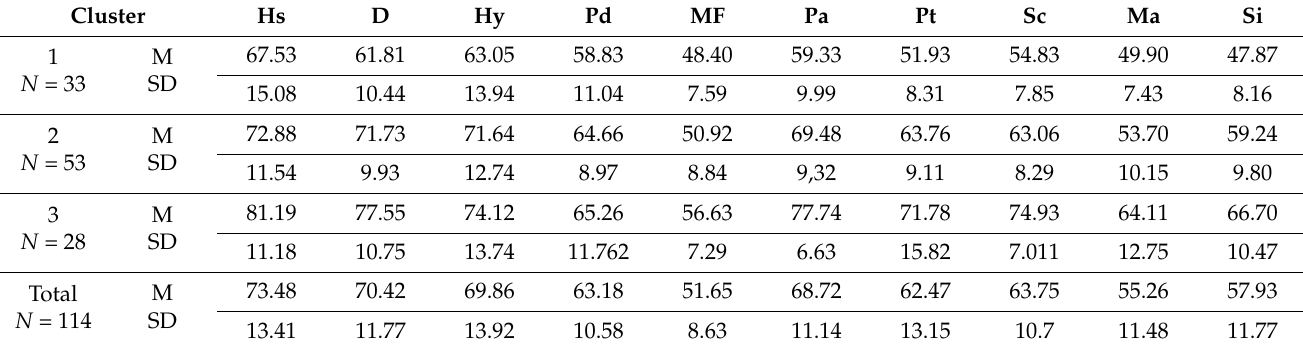
Table 10. Clinical scales for the three